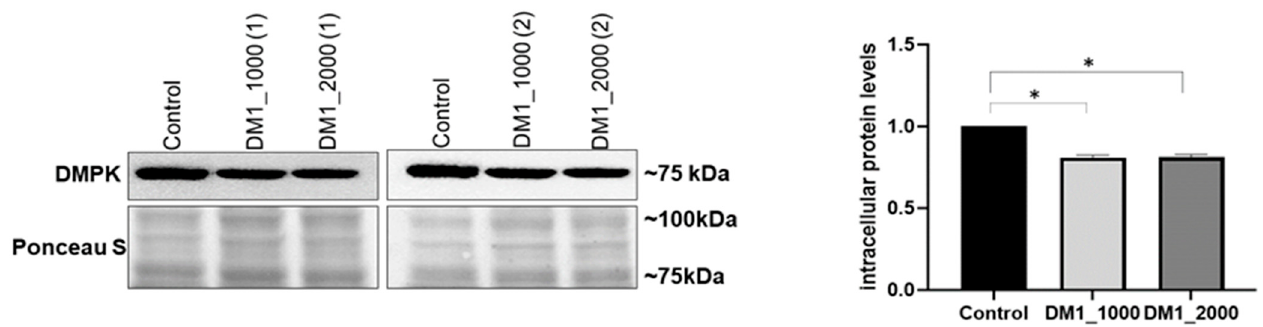
Figure 1. Intracellular DMPK protein levels in DM1 patient-derived and control fibroblasts. The intracellular protein levels in DM1 patient-derived fibroblasts were estimated in relation to the protein levels detected in the control condition and are presented as mean ± SEM of four independent experiments. Ponceau S staining was used to assess gel loading. The statistical analysis was performed using one-way ANOVA followed by the Tukey’s multiple comparison test, used to compare between DM1_1000, DM1_2000 and the control groups. * p < 0.05; DM1—myotonic dystrophy type 1; DMPK—myotonic dystrophy protein kinase; SEM—standard error of the mean.